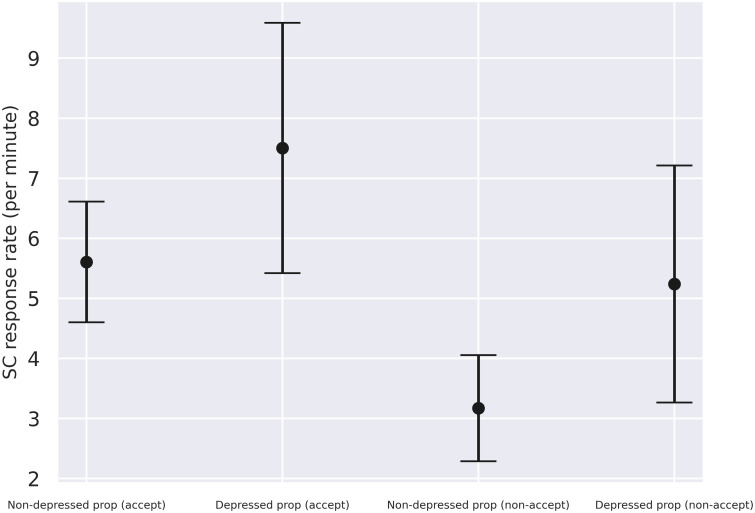
SC response rates in non-depressed and depressed proposers (prop) when the responses were accepting (accept) or non-accepting (non-accept).The black dots indicate means while the black bars represent 95% confidence intervals.